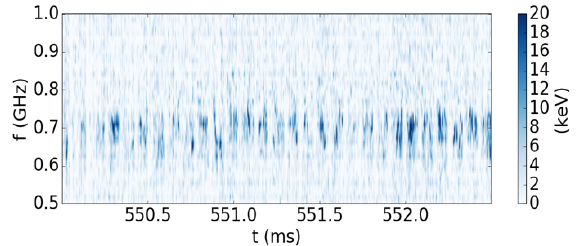
Fig. 13. Example of line-emission of Type 7 (shot #40735).